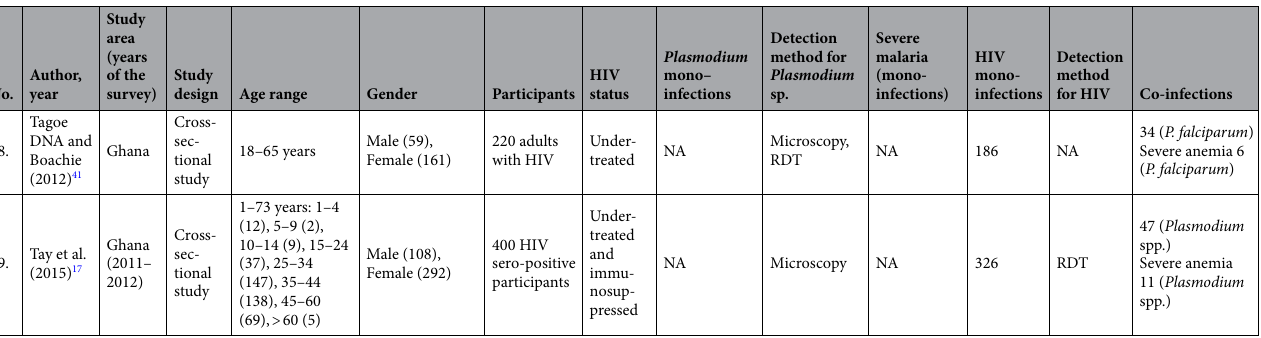
Table 1. Characteristics of the included studies. ELISA enzyme-linked immunosorbent assay, GCS Glasgow Coma Scale, IHC immunohistochemistry, NA not applicable, P. Plasmodium , PCR polymerase chain reaction, RDT rapid diagnostic